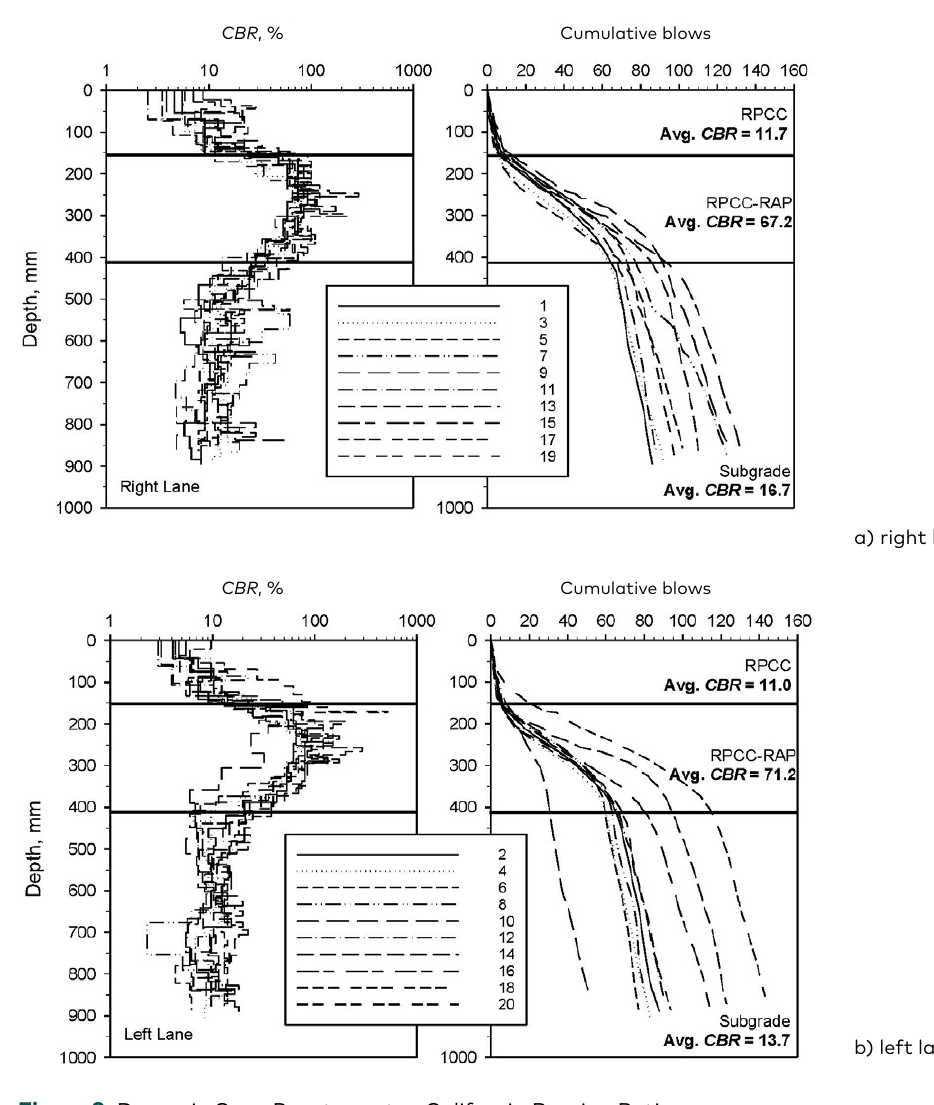
Figure 3. Dynamic Cone Penetrometer-California Bearing